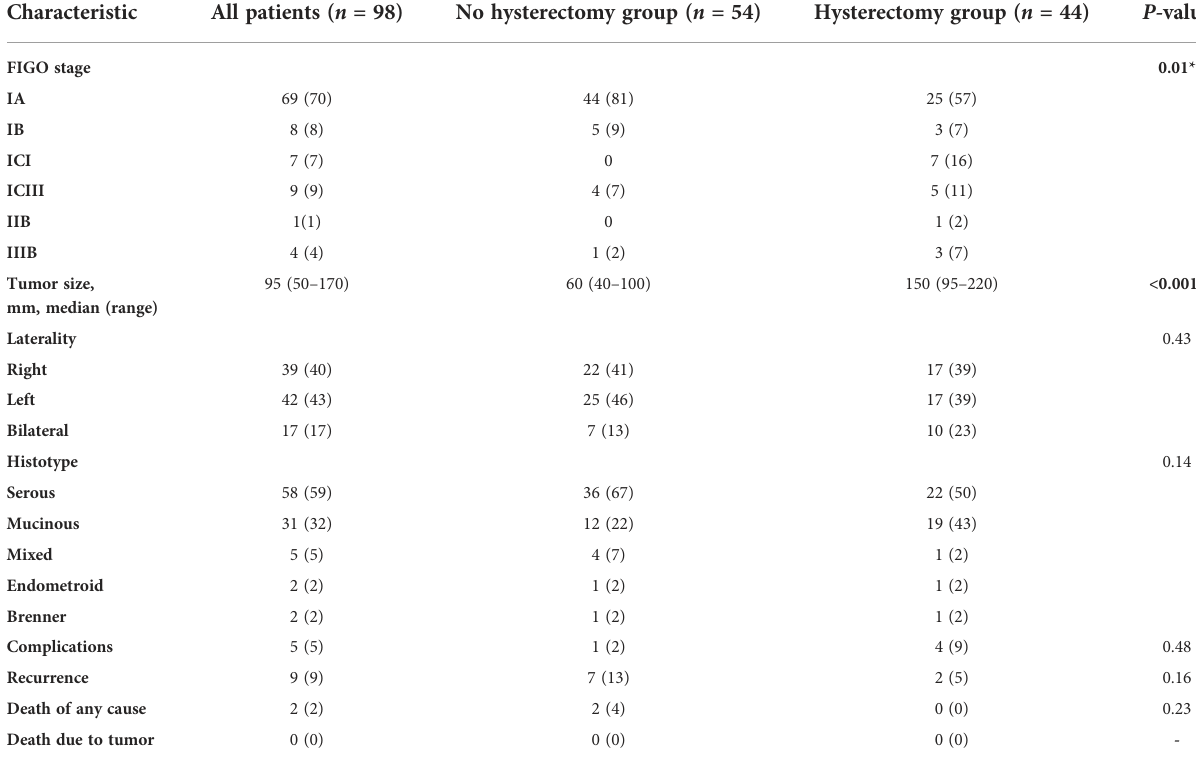
TABLE 2 Tumor characteristics and oncological outcomes of the study population. Characteristic All patients ( n = 98) FIGO stage